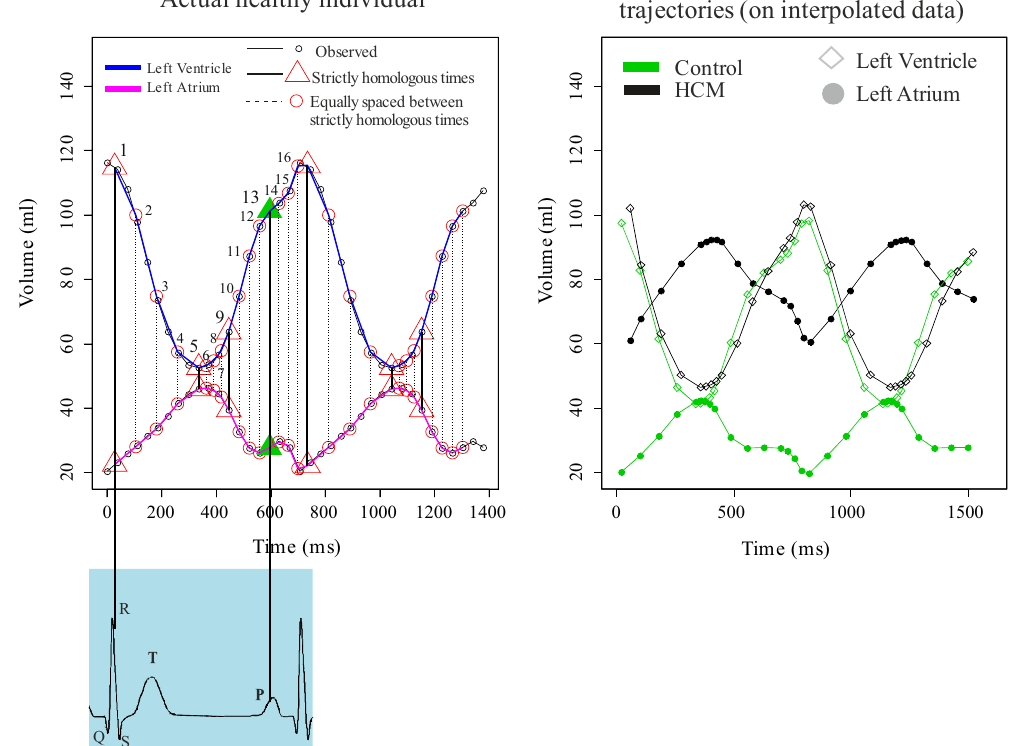
Figure 7. Interpolation procedure. The occurrence of homologous times (left) and mean volumetric trajectories of Control and HCM (right) are